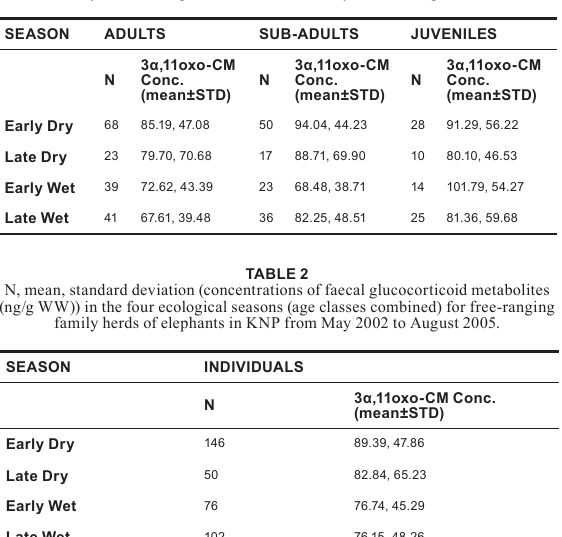
Table 1 N, mean, standard deviation (concentrations of faecal glucocorticoid metabolites (ng/g WW)) in the four ecological seasons (age classes separate) for free-ranging family herds of elephants in KNP from May 2002 to August 2005.